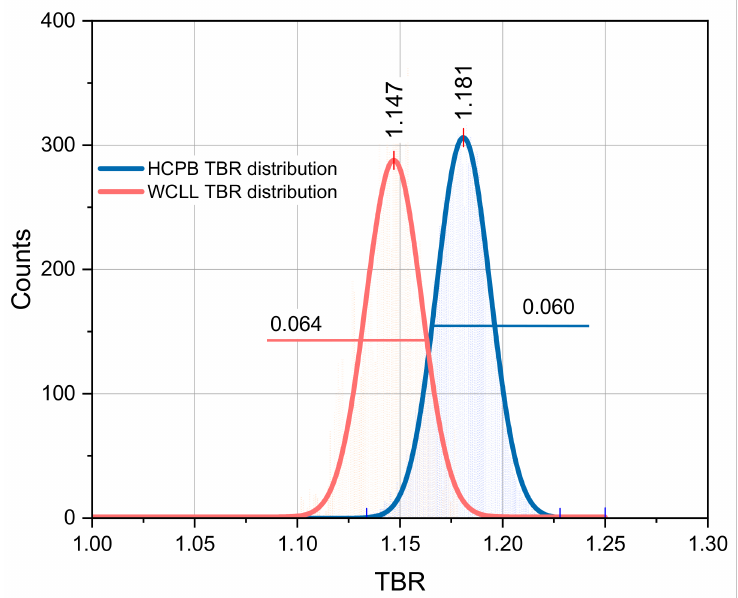
Figure 8. TBR statistical distributions with variated nuclear data for n+ 6 Li and n+ 9